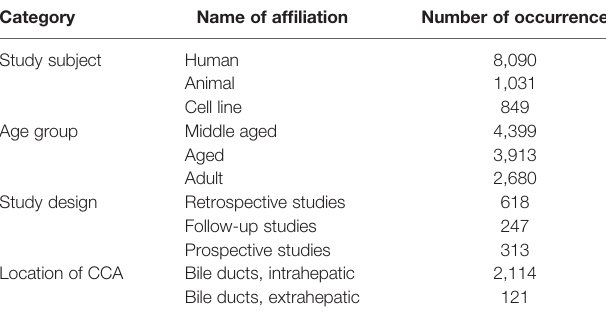
TABLE 2 | Top three terms in general issues of cholangiocarcinoma (CCA) studies during the past 25 years.